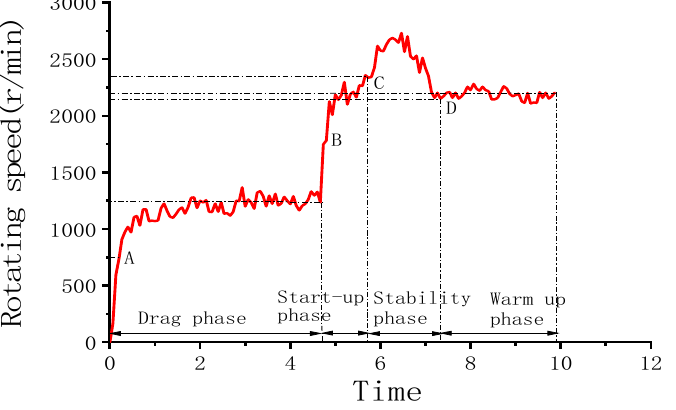
Figure 12. Cold-start phase of the engine.